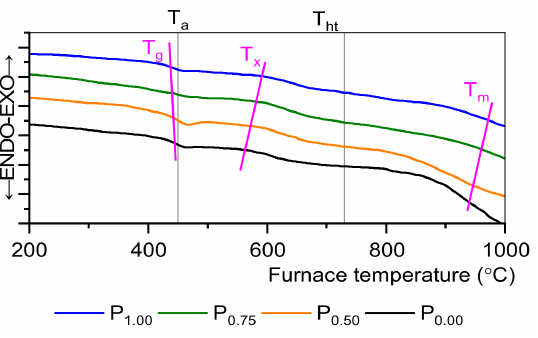
Figure 1. DSC curves. Temperatures: T g —glass transition, T ht —heat treatment, T x —crystallization, T a —annealing, and T c —crystallization